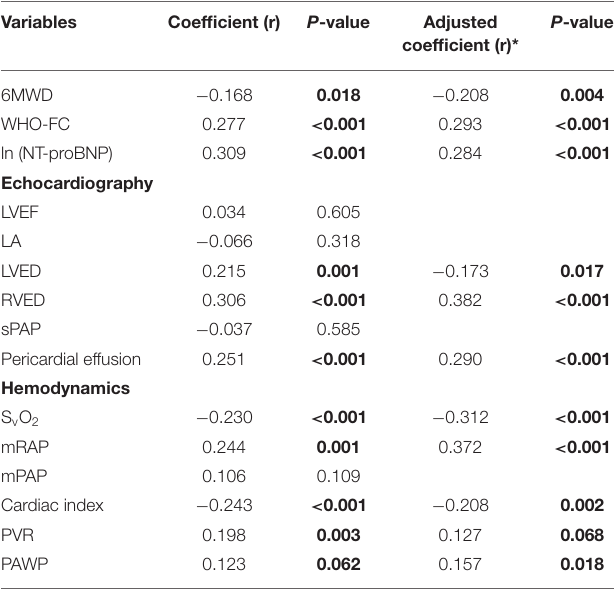
TABLE 2 | Correlations between carbohydrate antigen 125 and established markers of PH severity.